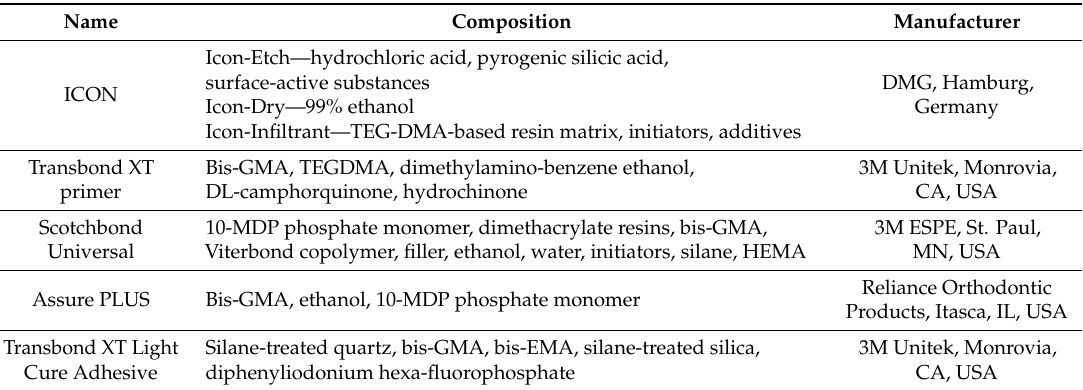
Table 1. Materials used in the present